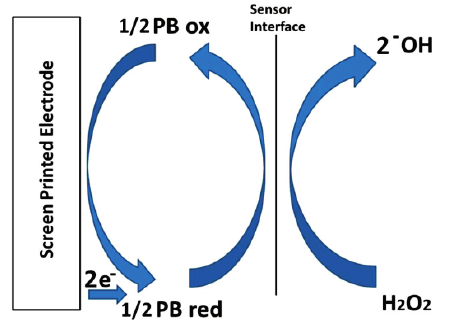
O reduction mediated by 2 2